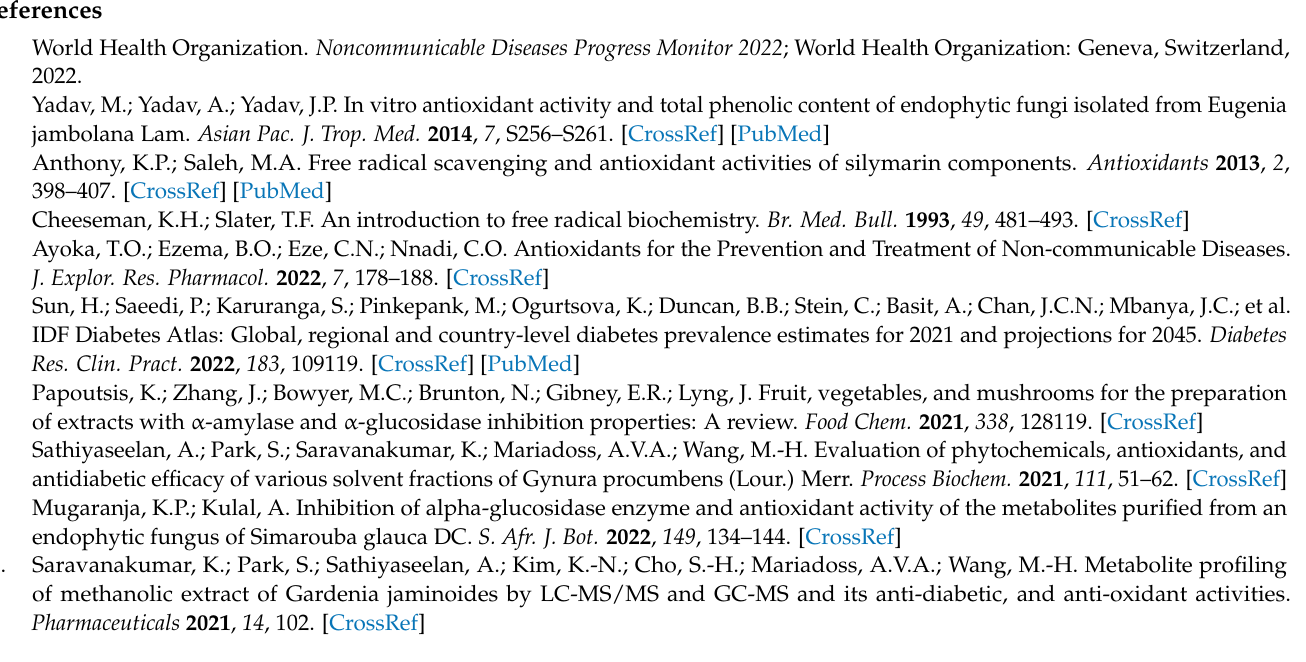
ligase; Table S3: Summary of the hydrogen bonding and Van der Waals interactions with